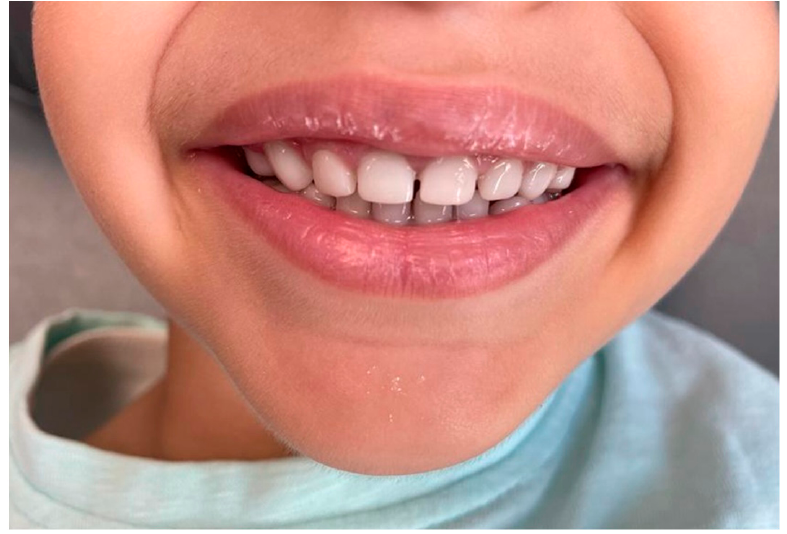
Figure 6. Smile integration at 6 months post-procedure.